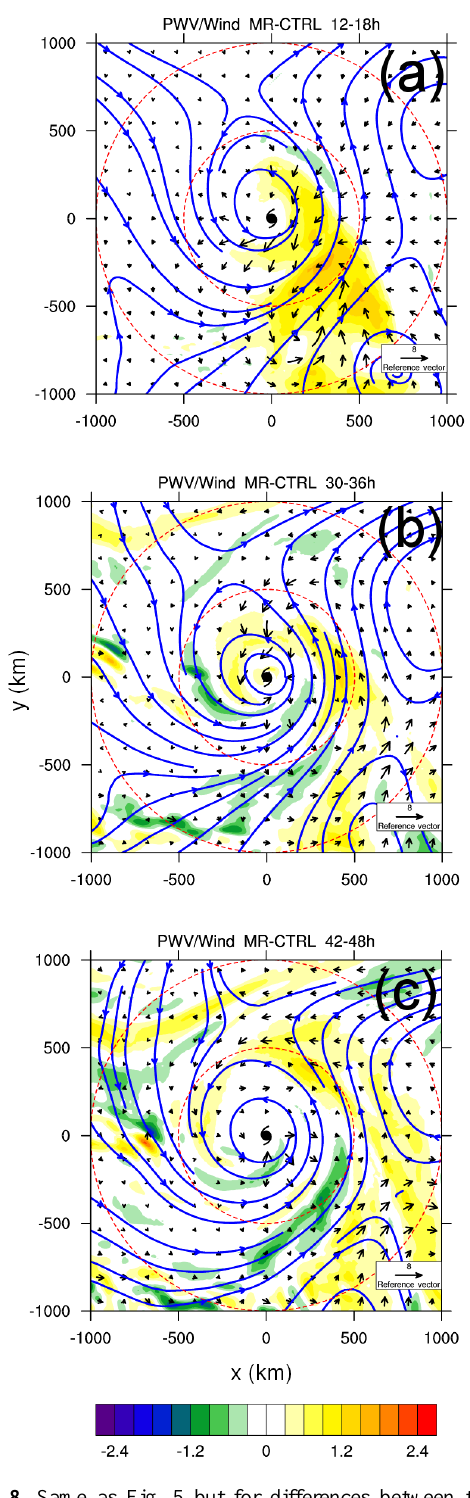
Figure 8. Same as Fig. 5 but for differences between the MR and CTRL experiments. Mean wind vectors and column-integrated PWV for CTRL and MR at each time are shown in Fig. S1 in the